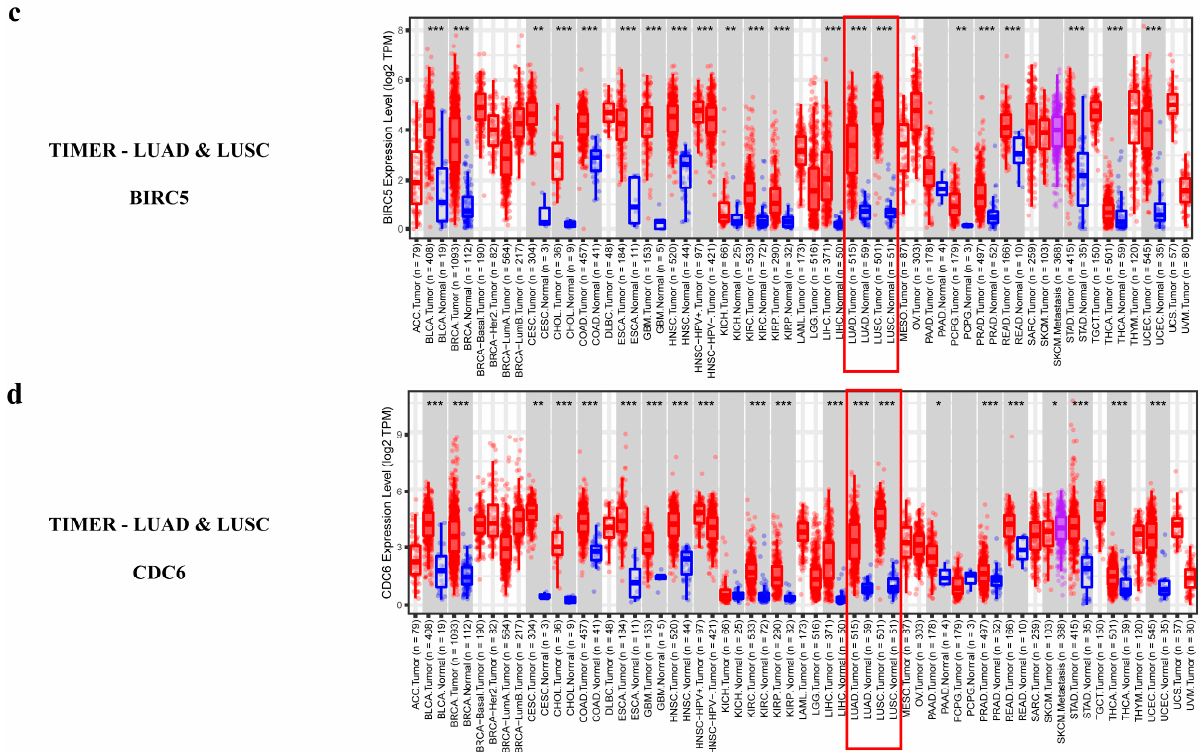
Figure 21. Differential expression of YWHAG , YWHAQ , BIRC5 , and CDC6 in the TIMER: ( a ) YWHAG mRNA expression data of LUAD and LUSC in TIMER; ( b ) YWHAQ mRNA expression data of LUAD and LUSC in TIMER; ( c ) BIRC5 mRNA expression data of LUAD and LUSC in TIMER; ( d ) CDC6 mRNA expression data of LUAD and LUSC in TIMER. The blue dots/boxs indicate the normal samples, while the red dots/boxs indicate the tumor samples. *: p < 0.05; **: p < 0.01; ***: p < 0.001.